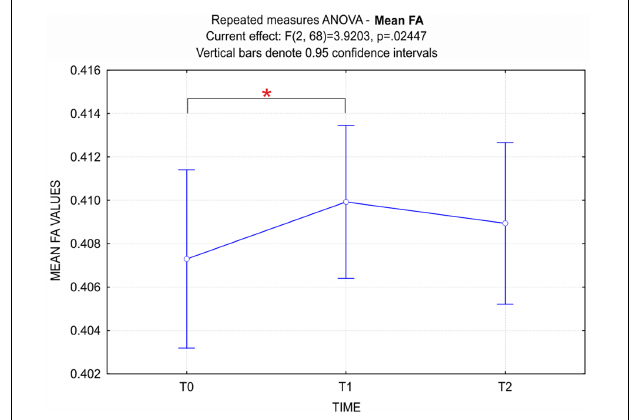
FIGURE 5 | ANOVA repeated measures - Time (3) factor for mean FA values. Data show a significant principal effect for the Time factor. Bonferroni post hoc correction showed that FA values at T1 were significantly higher than at T0 ( p < 0.05). It should be noted that, although not significantly different, FA values at T2 were lower than at